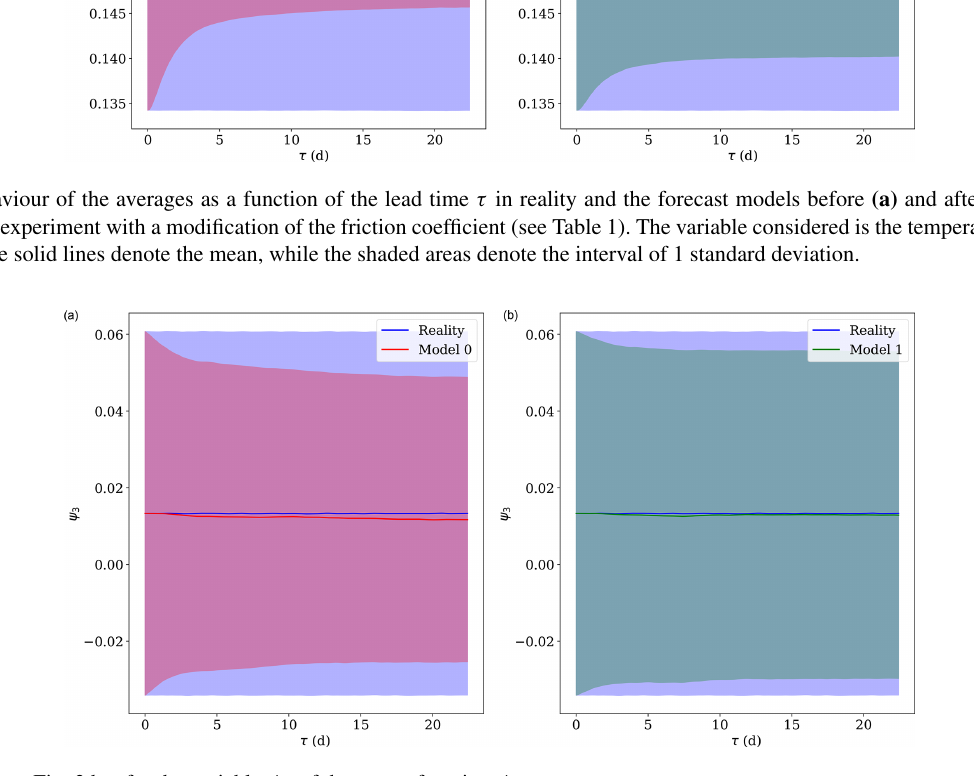
Figure 4. Same as Fig. 3 but for the variable ψ 3 of the streamfunction ψ